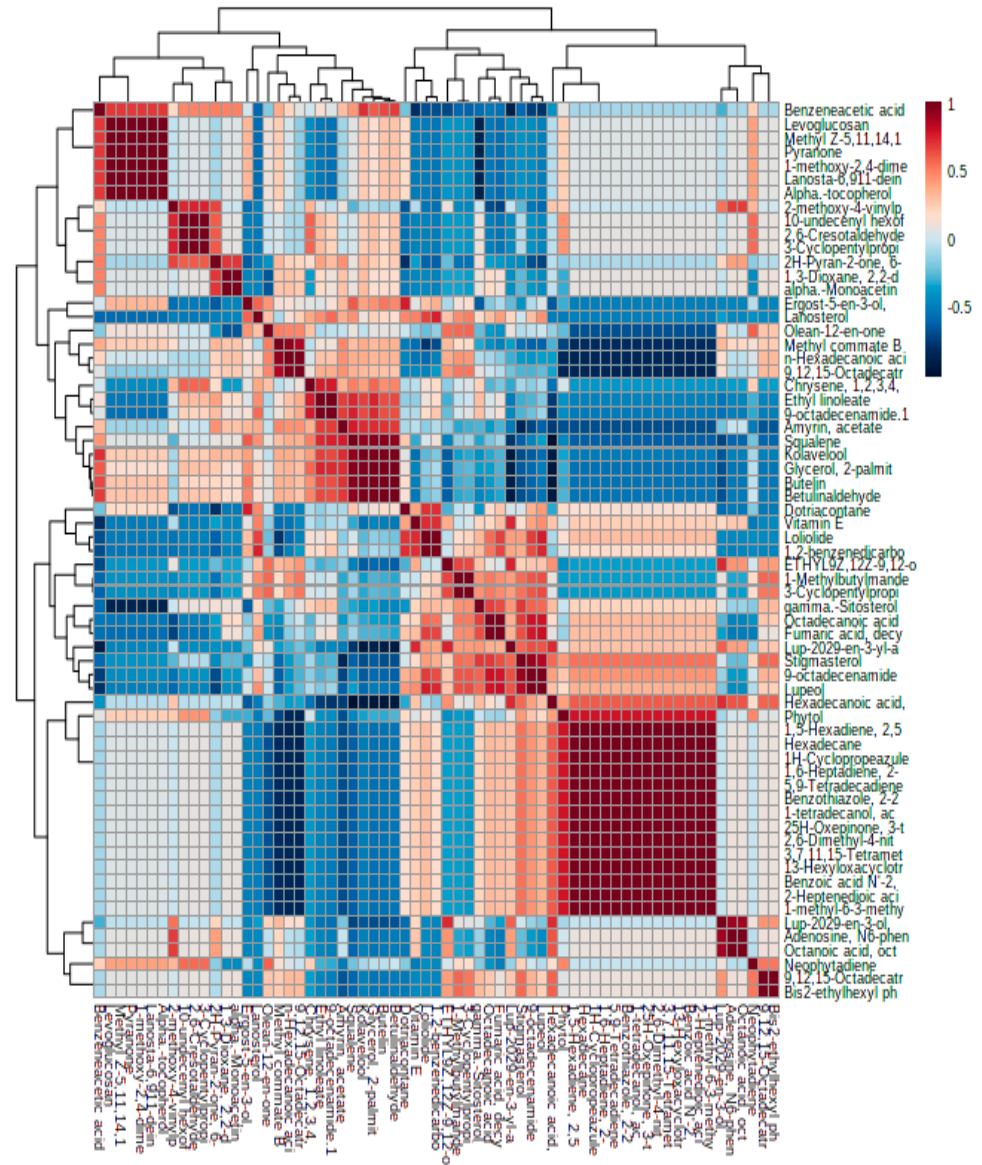
Figure 4. Pearson’s correlation analysis among the different metabolites of chicory accessions from different altitudinal areas.